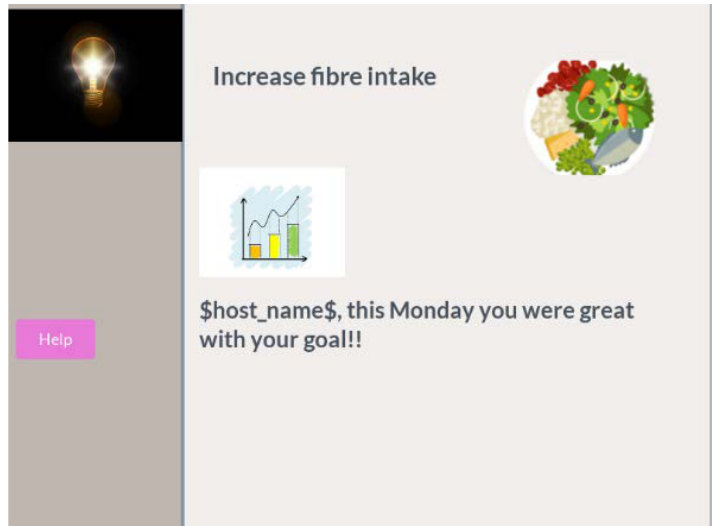
Figure 17. Day insight goal performance.